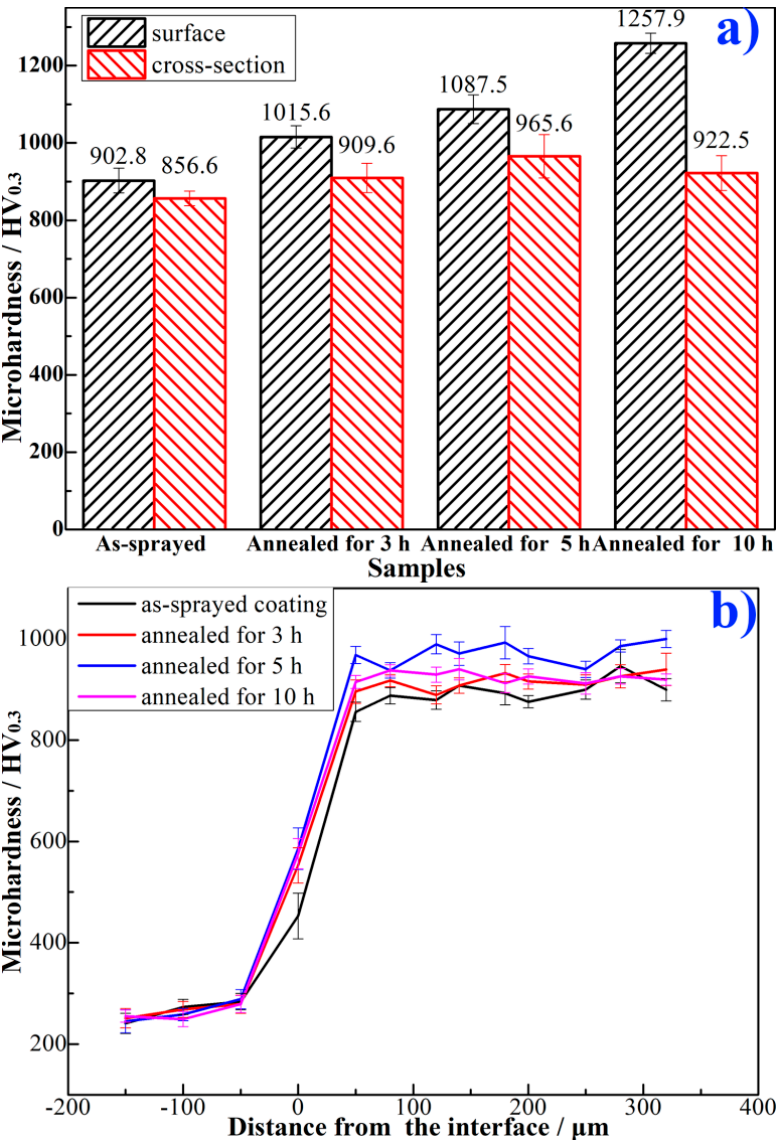
Figure 6. Average microhardness of the CoMoCrSi coatings ( a ) and variation across the thickness ( b ).